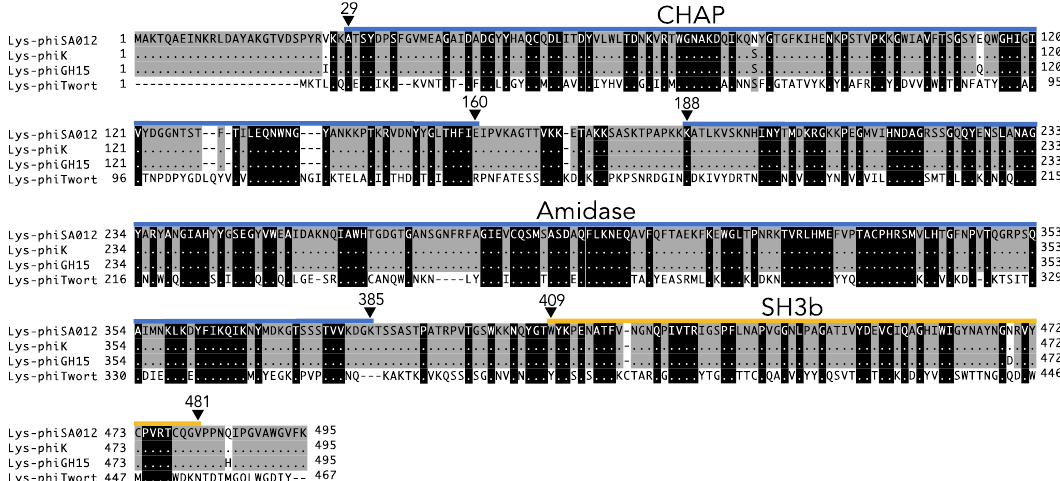
Figure 1. Prediction of the domain architecture and multiple alignment analysis of Lys-phiSA012. Lys-phiSA012 is composed of a CHAP, AMID, and SH3b domain. The amino acid sequence of Lys-phiSA012 was analyzed using InterPro. Blue and yellow lines indicate the domain structure of Lys-phiSA012. Multiple alignment analysis of the full length endolysins Lys-phiSA012, Lys-phiK, Lys-phiGH15, and Lys-phiTwort. Identical residues are shown as dots and amino acid residues conserved between the four endolysins are highlighted by a black (100%) or gray (80%) scale.